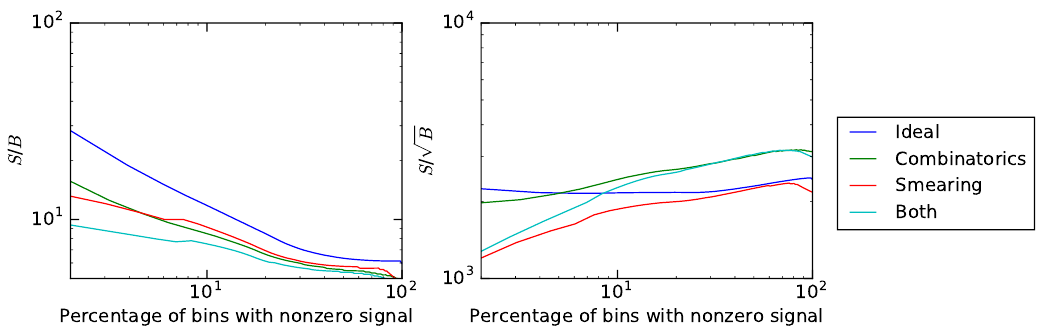
Figure 11 . The e(cid:11)ect of energy resolution and combinatorics on the signi(cid:12)cance performance curve of (cid:1) 4 is shown using the S = B (left panel) and S = p B (right panel) metrics.